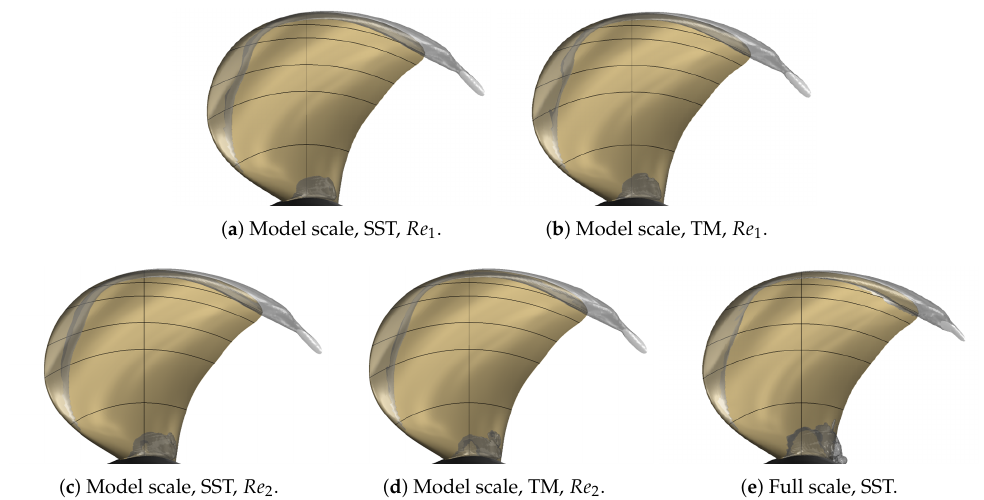
Figure 22. Comparison of the predicted near-blade cavitation observation for the PPTC Case 1 in model- and full-scale conditions.